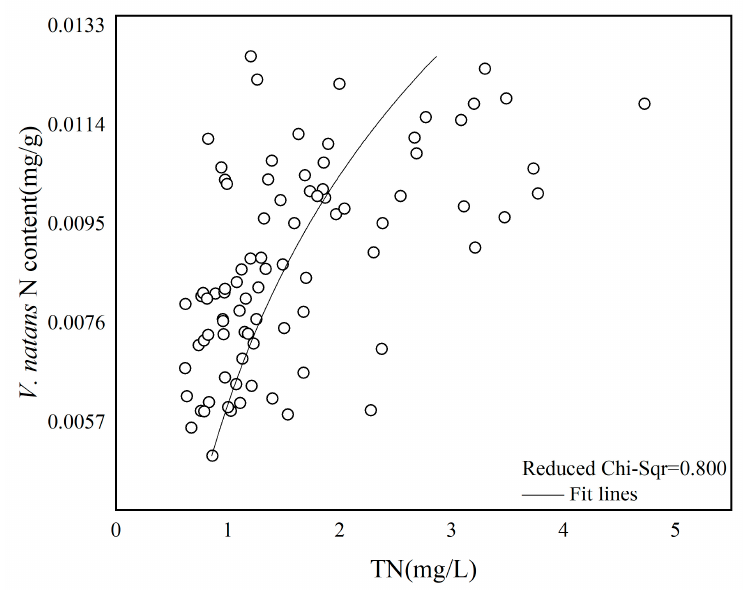
Figure 6. The relationship between V. natans N and water TN. Table 7. Summary of the best model of the relationship between V. natans P and water N:P.